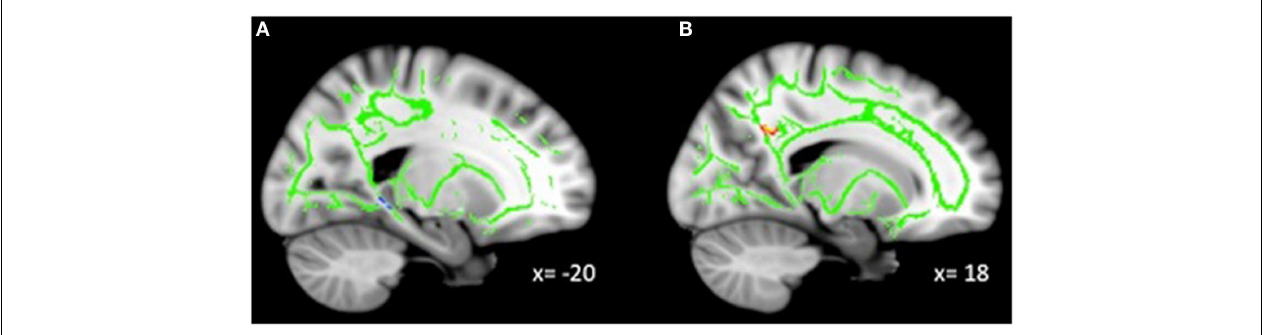
FIGURE 1 | (A) IncreasedWM integrity in the MDD group vs. HC in the posterior cingulum near the hippocampus; (B) decreasedWM integrity in the MDD group vs. HC in the anterior cingulum near the